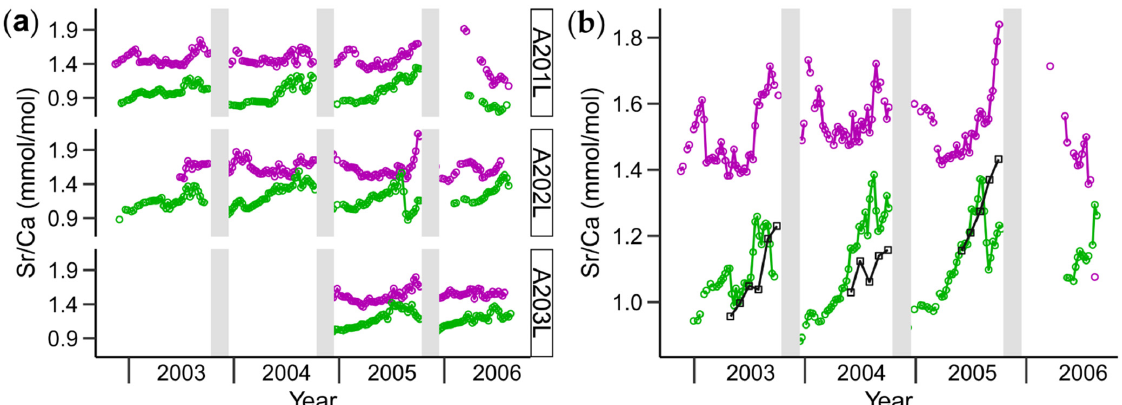
Figure 3. Shell Sr/Ca chronologies of the three studied specimens (A201L, A202L and A203L) of Arctica islandica . Magenta open circles = data from the outer portion of the outer shell layer (oOSL; homogeneous microstructure, HOM) of the ventral margin; green open circles = data from the inner portion of the outer shell layer (iOSL; crossed-acicular microstructure, CA) of the ventral margin; black open squares = data from the hinge (CA). Vertical gray bars denote annual growth lines. ( a ) Sr/Ca chronologies of each specimen and sublayer of the outer shell layer (oOSL, iOSL). ( b ) Average Sr/Ca chronologies computed from curves depicted in ( a ). Data from the ventral margin are weekly resolved. Monthly Sr/Ca data of the hinge (data from all studied specimens combined) are shown for comparison.